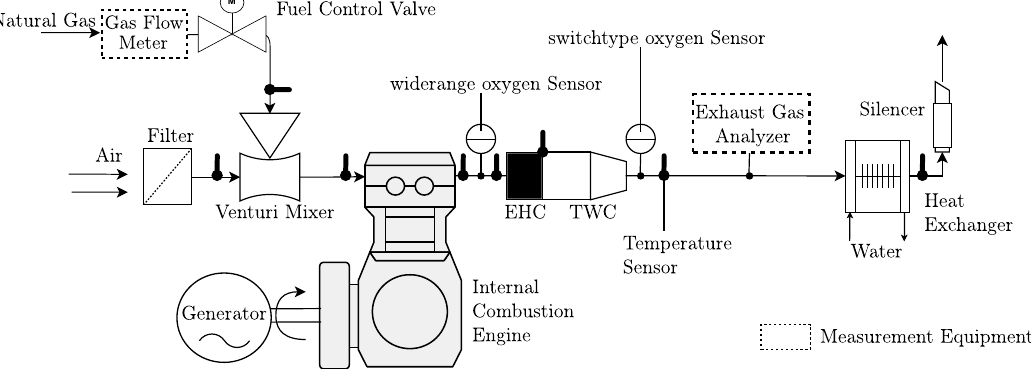
Figure 1. Schematic representation of the airpath; data of measurement equipment in Table A1 of Appendix